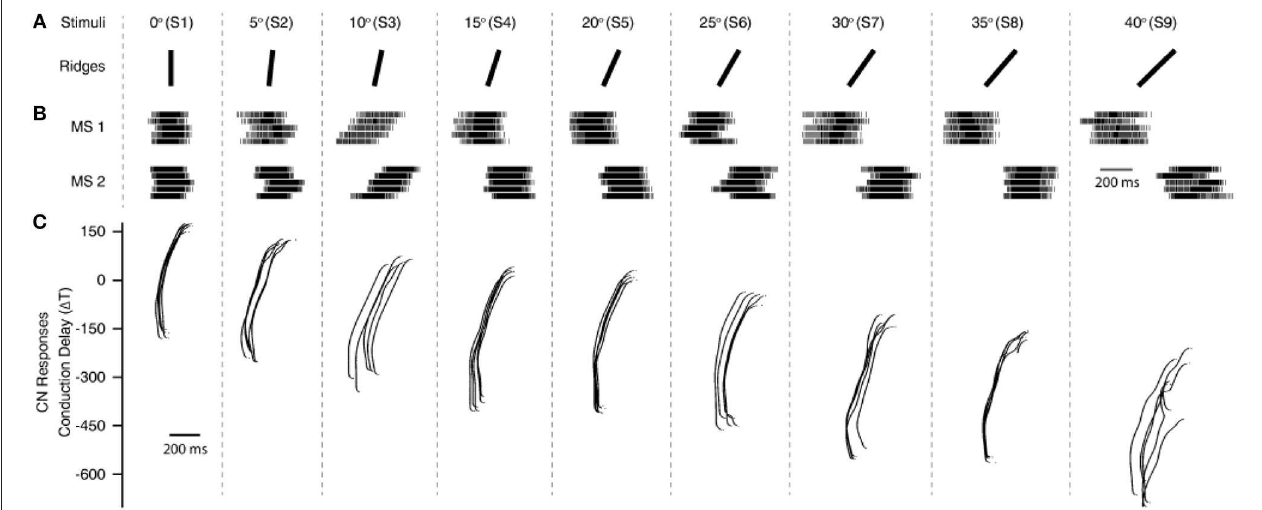
FIGURE 4 | Processing stimuli orientation. (A) Representation of all 9 stimuli, with ridge angles ranging from 0 to 40 ◦ with a step of 5 ◦ . (B) Artificial mechanosensors spike train responses (MS1 and MS2, 1st order neurons) encoded using Izhikevich neuron model based on the tactile sensor data input (MS1 and MS2 responses associated to the analog data from sensory channel 8 and 11, SC8 and SC11 from Figure 1 ). The five spike train responses for each mechanoreceptor, show the 5 experimental repetitions for each stimulus. (C) , Cuneate neurons (CNs, 2nd order neurons) responses for all 9 stimuli (S1–9), across a range of differential conduction delays varying between 175 and − 700ms, with a step of 1ms. The illustrated responses of MSs and CNs are for a single sensing force (Z1 from Figure 3C ) and sensing velocity (5 mm/s) of the experimental protocol.